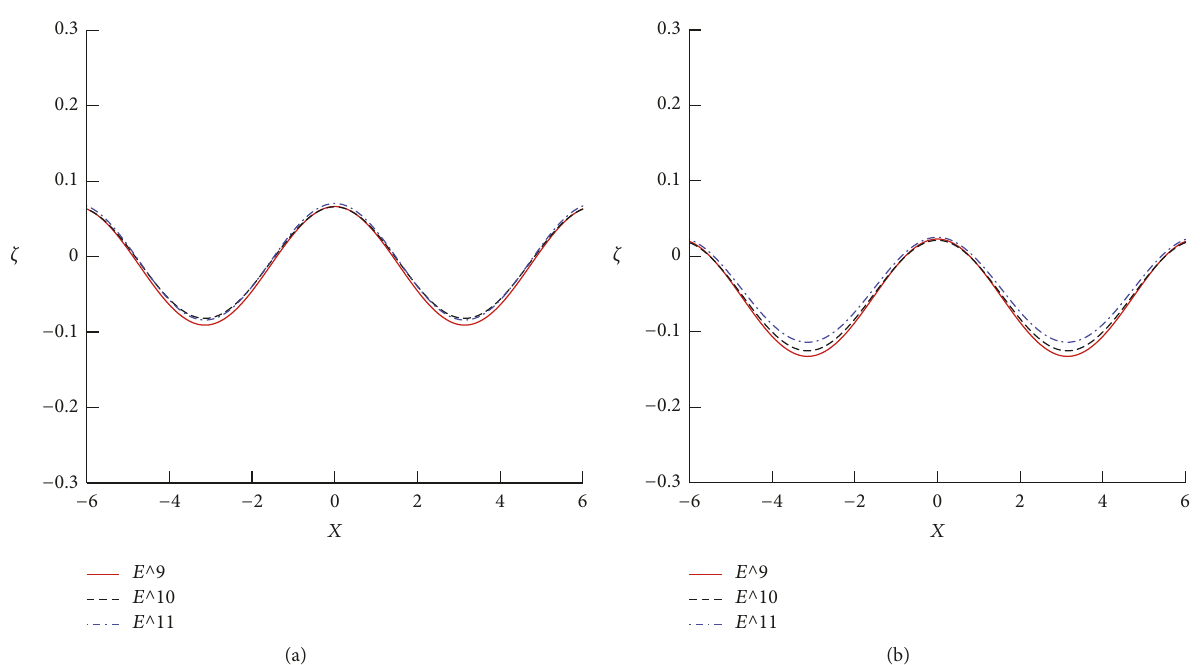
Figure 6: Variation of the hydroelastic wave profiles versus 𝑥 for different value of Young’s modulus on a following current. (a) 𝑈 1,0 = 0.1 . (b) 𝑈 1,0 = 0.3